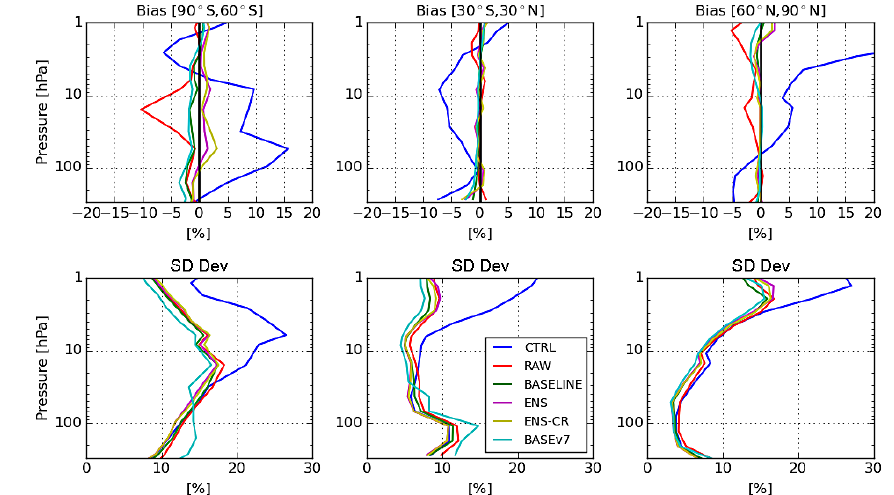
Figure 4. Mean (top) and standard deviation (bottom) of (BASCOE − MIPAS) / MIPAS for CH 4 , for six BASCOE experiments (see text for details) and for the period September–October 2008. Left corresponds to South Pole (90–60 ◦ S), centre corresponds to the tropics (30 ◦ S– 30 ◦ N) and right corresponds to North Pole (60–90 ◦